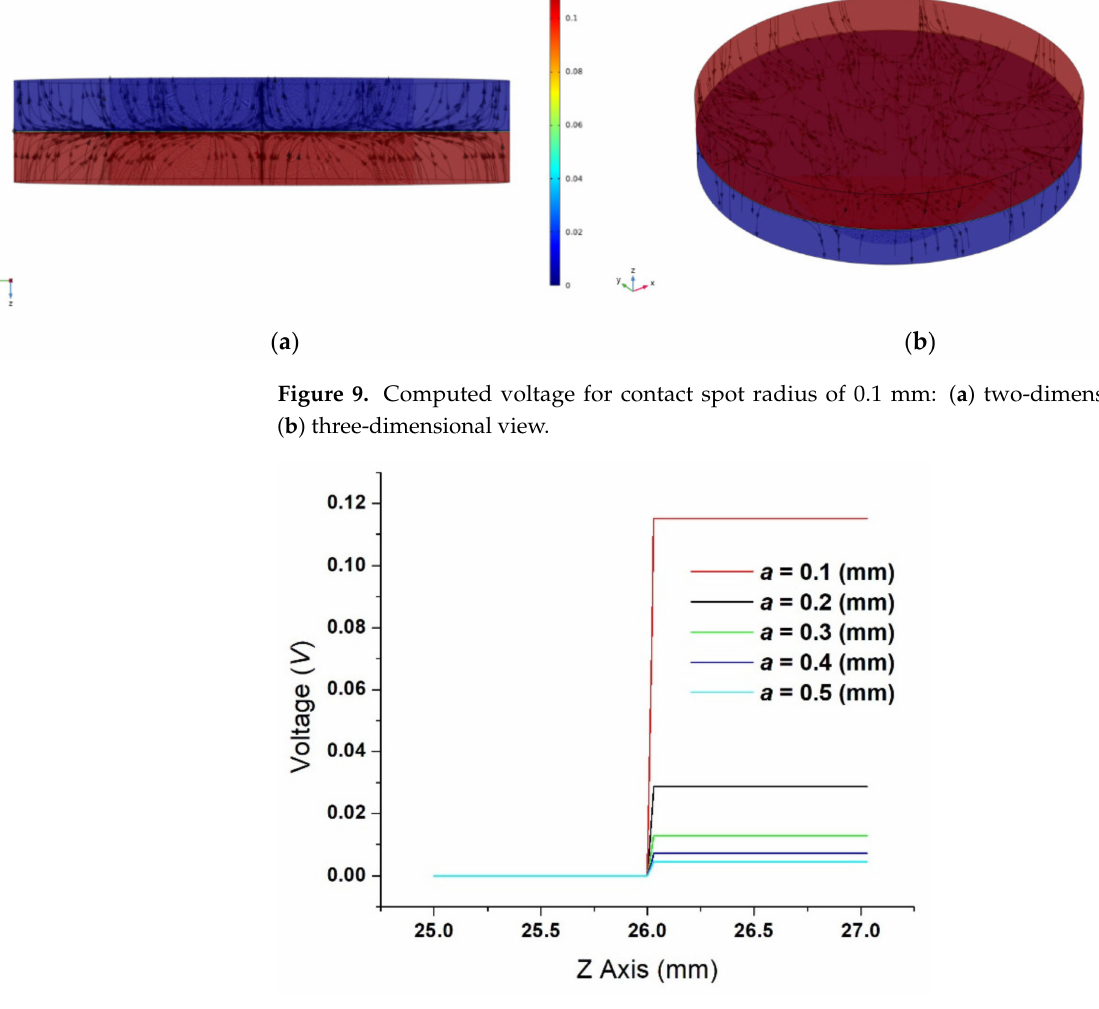
Figure 10. Voltage-drop for different values of contact spot radius a = (0.1 mm/0.5